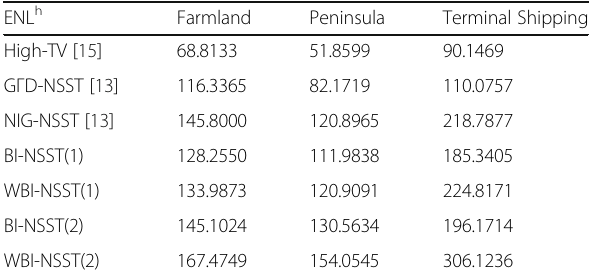
Table 6 ENL h to compare the performance of our proposed methods and references [13] and [15] for despeckling a real SAR image called Farmland, Peninsula, and Terminal Shipping